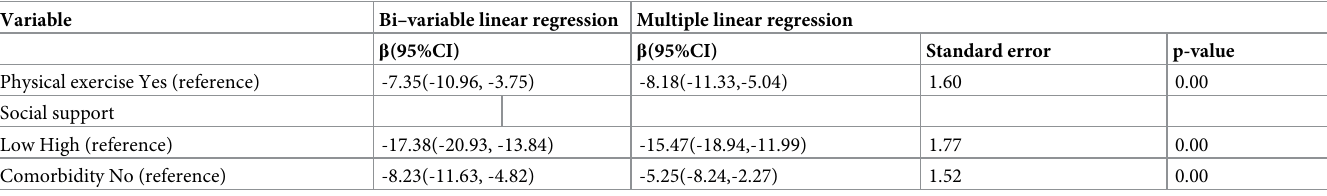
Table 8. Multivariable linear regression model on factors associated with environmental domain of HRQoL among adult hypertensive patients on treatment at public health facilities in Dessie City Administration, Northeast Ethiopia, 2021 (n =